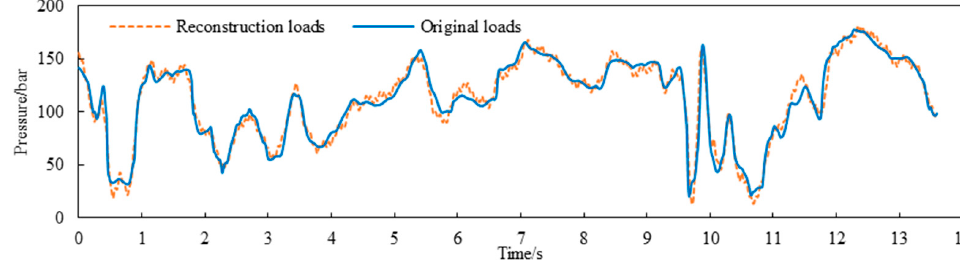
Figure 18. Comparison between reconstructed load and original data.